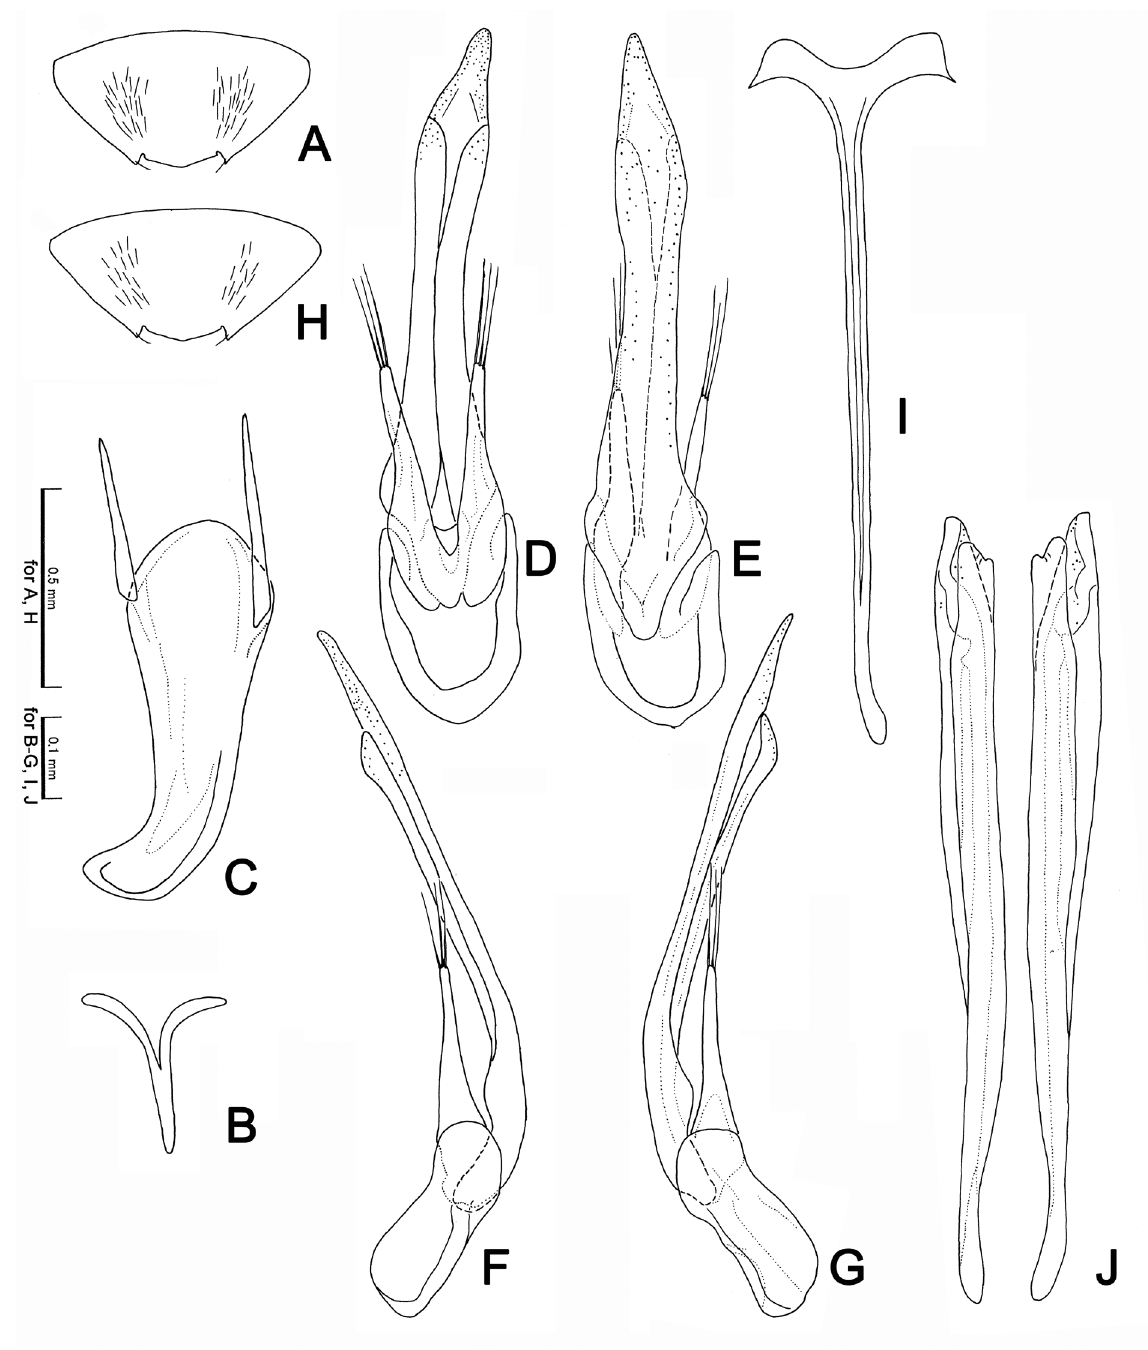
Fig. 12. Mexico ogasawaraensis sp. nov., male (A–G) and female (H–J) genitalia (paratypes, EUMJ). A, H . Sternite VII. B . Sternite VIII. C . Sternite IX. D . Aedeagus, ventral view. E . Aedeagus in dorsal view. F . Aedeagus in right lateral view. G . Aedeagus, left lateral view. I . Urosternite. J